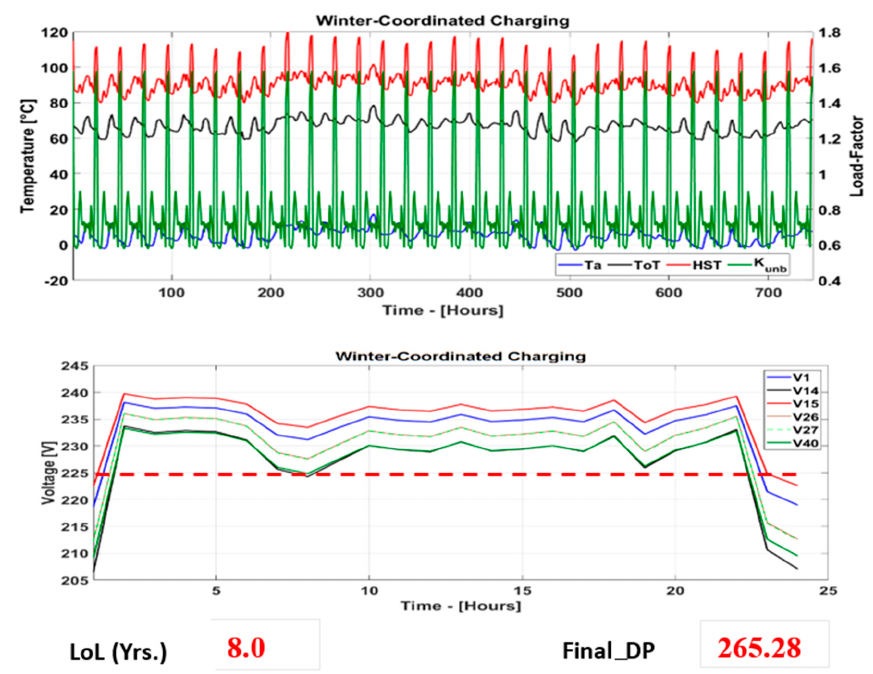
Figure 7. Output under coordinated charging across selected households, during winter, without BESS.